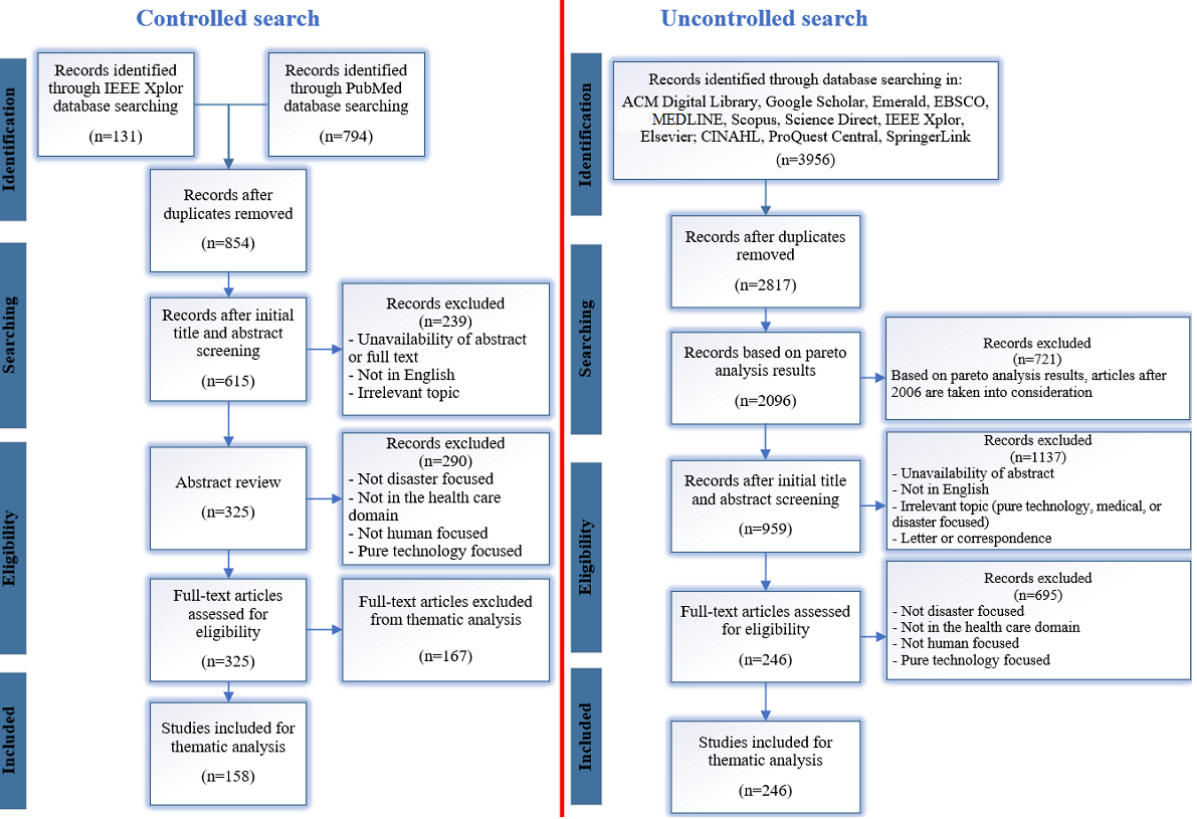
Figure 3. Controlled and uncontrolled searching steps. CINAHL: Cumulative Index to Nursing and Allied Health Literature; EBSCO: Elton B Stephens